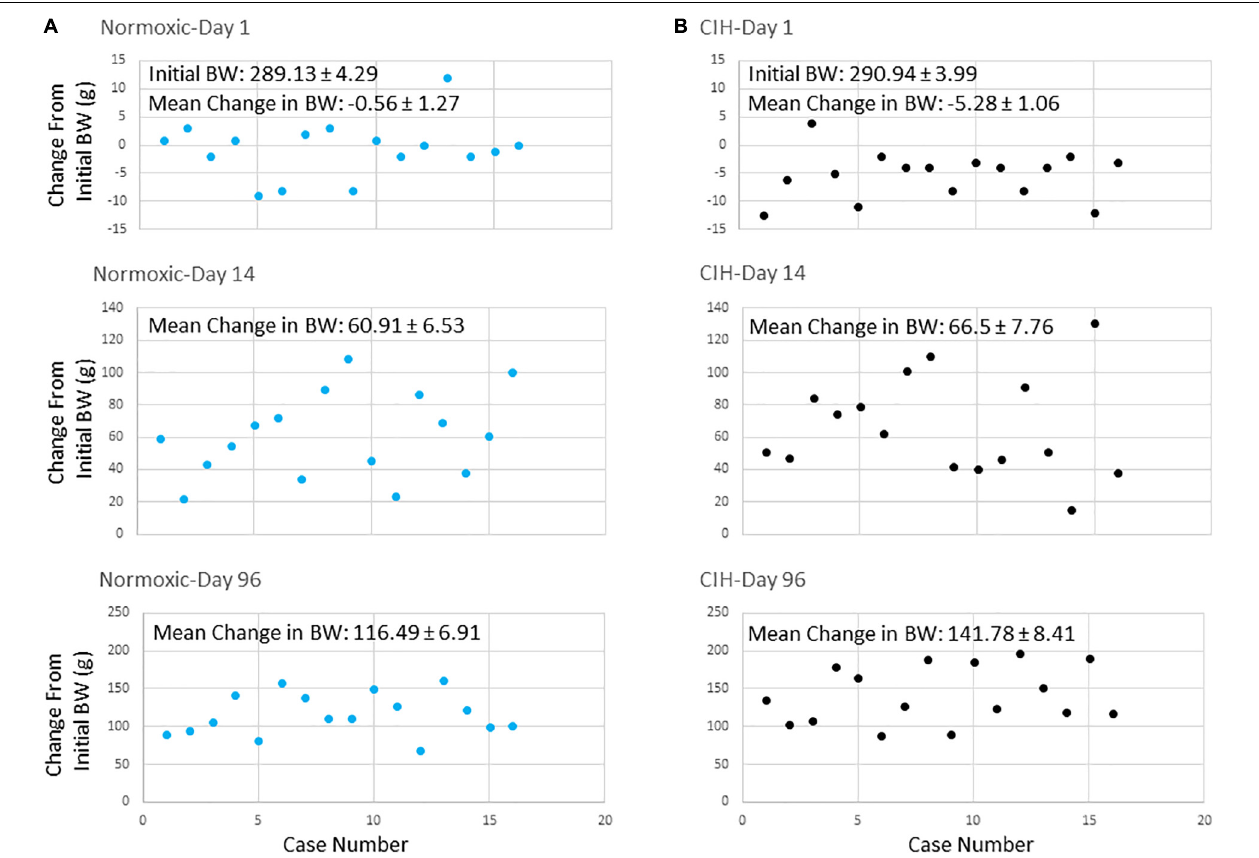
FIGURE 3 | (A,B) Are scatter plots showing body weight changes from initial body weights at the start of the study at days 1, 14, and 96 after either normoxic ( n = 16) or CIH ( n = 16) exposure. Note that after 24 h exposure on day 1, body weights decreased in the CIH group (B) but not in the normoxic group (A) . By day 14, body weights were similar in both groups. However, by day 96, body weights of the CIH group were elevated compared to normoxic